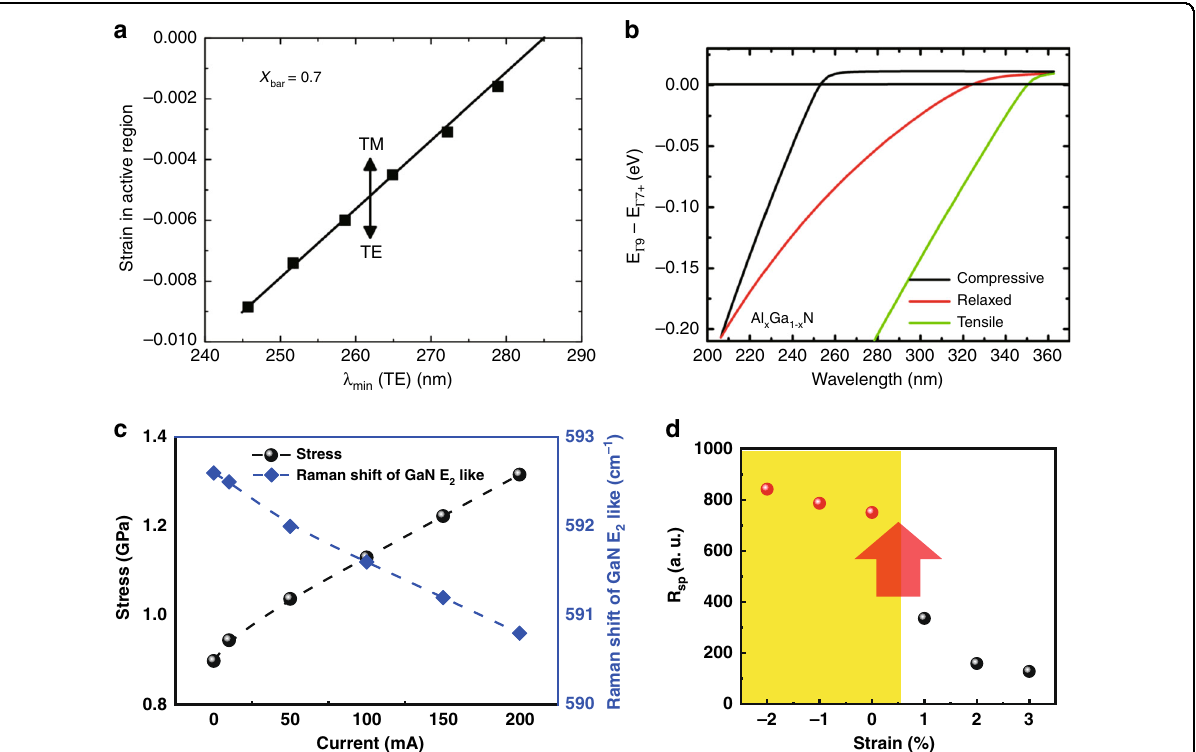
Fig. 7 The strain fi eld effect on the energy band structure, transition and emission in AlGaN quantum structures. a The strain in active region required to achieve TE polarization at prescribed wavelengths. b Calculated energy spacing between the Г 9 and Г 7 + VBs for fully compressive AlGaN grown on AlN, fully relaxed AlGaN, and fully tensile AlGaN grown on GaN. c The biaxial stress of AlGaN MQWs derived from stress-free Al 0.52 Ga 0.48 N as a function of current. d The calculated total spontaneous emission rate as a function of strain. Figures reproduced from a ref. 97 , © 2012 AIP Publishing; b ref. 98 , © 2015 AIP Publishing; c and d ref. 103 , © 2017 The Royal Society of